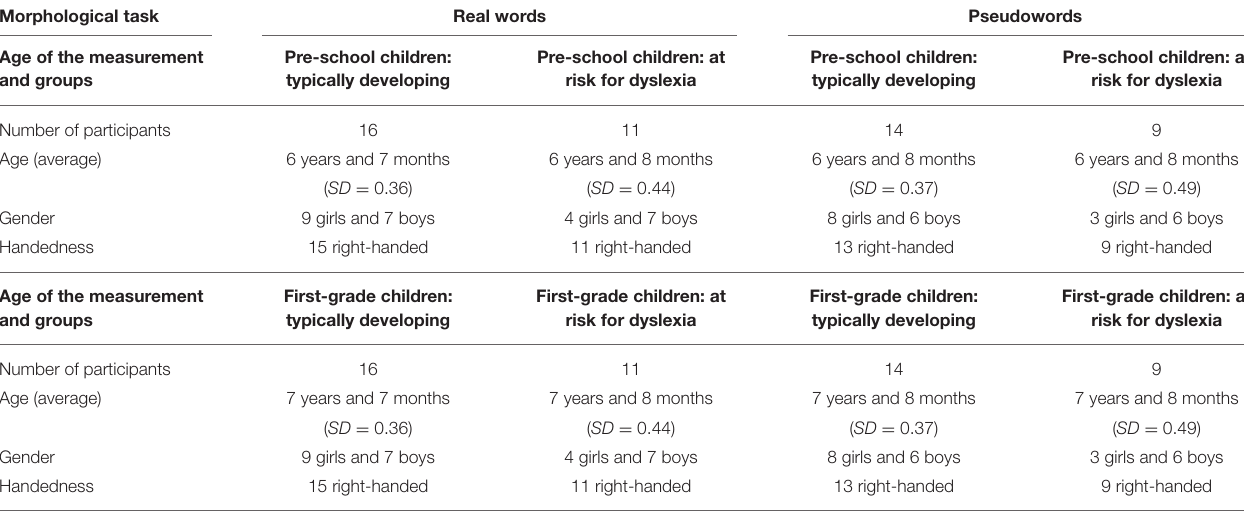
TABLE 1 | Demographic information of the pre-school and first-grade children included in the data analyses. Morphological